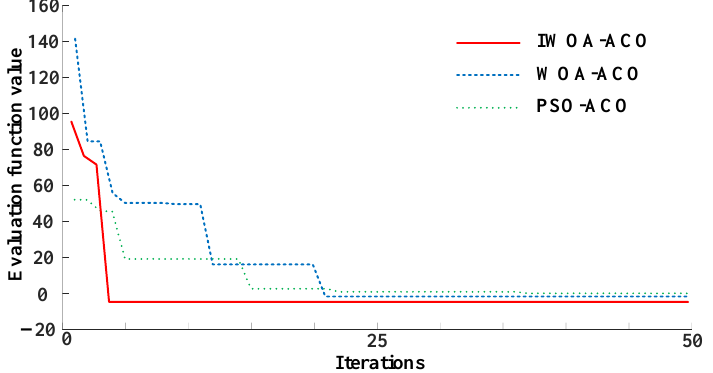
Table 4. The parameter values of ACO in the simulation of bump environment.